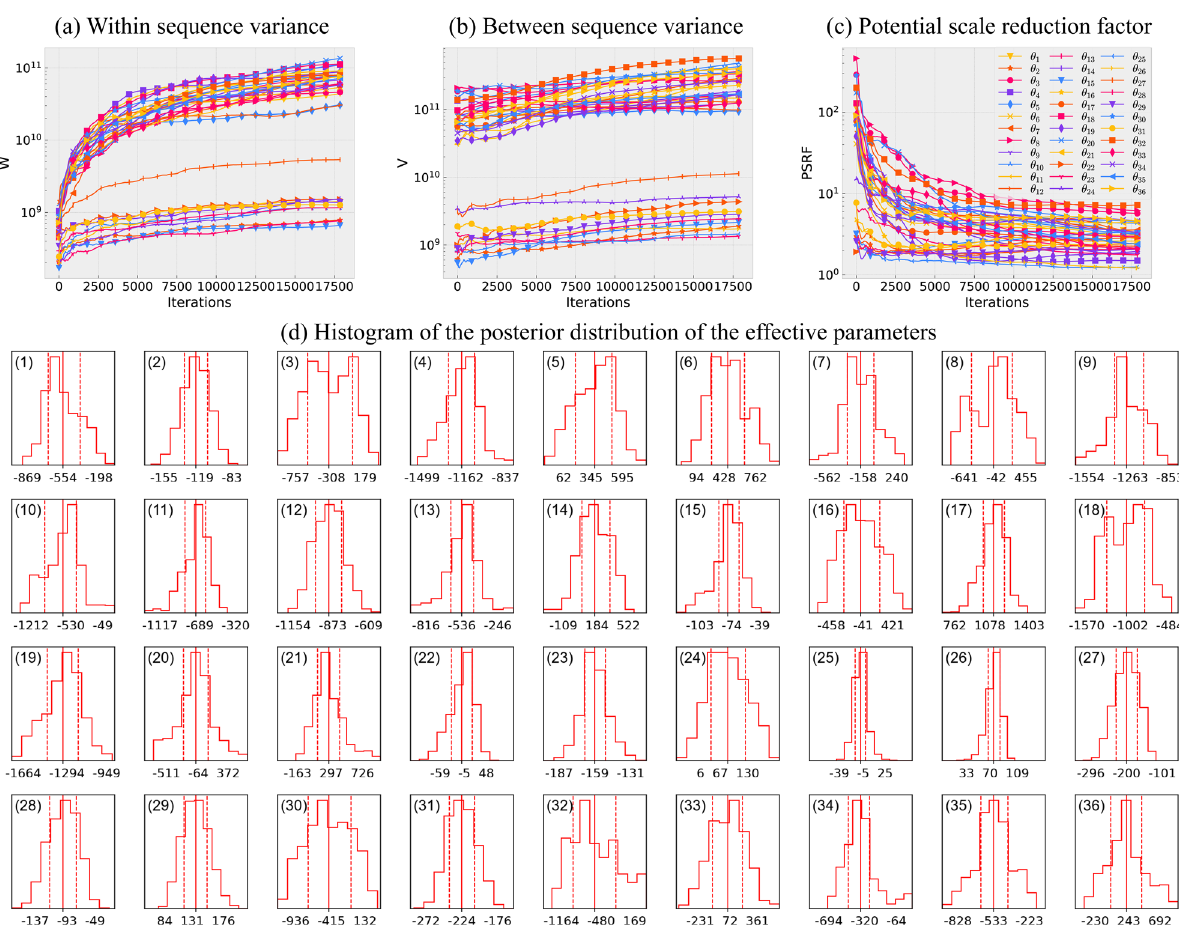
Fig. 5 Statistics over the sequences of samples. Samples are drawn by means of the Metropolis – Hastings algorithm with 12 independent chains. Statistics are a Within sequence variance, b Between sequence variance and c Potential scale reduction factor of the MCMC sequences. d Histogram of the posterior distribution of the effective parameters, while all estimations have been divided by 10 3 and speci fi c notions of the parameters are indexed in Supplementary Table between the observations and the predictions, i.e., as illustrated in Fig. 7. They are the distributions of the prediction biases due to variable-selection genetic algorithm, L 1 /L 2 norm regularization and MCMC. The histograms of distributions are very similar to each other, though the estimations of the algorithms are quite different, as listed in Supplementary Table 3. Variable-selection genetic algorithm with AIC and BIC, L 1 /L 2 norm regularization achieve similar mean square errors as denoted as star in Fig. 7. Among the three strategies, the variable-selection genetic algorithm performs slightly better, as the prediction biases tend to concentrate more obvious around zero than the others. When it comes to the estimations produced by MCMC, the related fi tting goodness is much better than the above three strategies as the related RSS is smaller. In trade of better overall fi tting goodness, the prediction biases to the observations concentrate less signi fi cantly around 0 regarding the maximum a-posterior. Reason for difference in performance of different algorithms also lies in optimization criteria of the algorithms. Joint parameter selection and estimation is subjected to the information criteria, where the fi tting goodness or RSS is partly concerned in the cost function. When most appropriate subset of parameters are selected, the estimated parameters are closed to the maximum likelihood estimation θ MLE . Regularization is expected to reduce the complexity of the concerned model by means of imposing additional penalty in the cost function. With the proposed regularization algorithm, results of regularization, i.e., θ ReL1 and